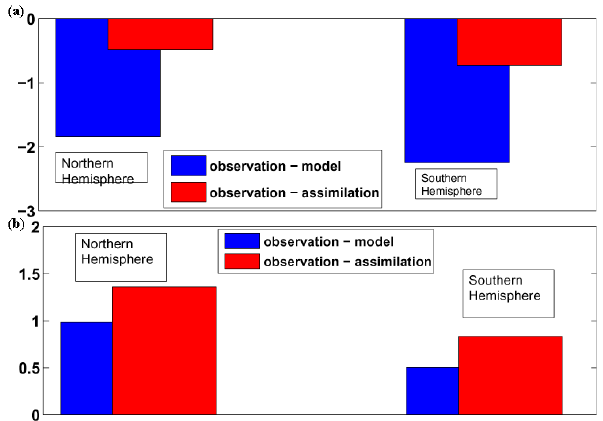
Fig. 6. Mean (a) and standard deviation (b) differences (O − M or O − A) between NOAA/ESRL/GMD cooperative air sampling net- work and model (blue) or analysis (red) fields interpolated to obser- vation locations. These plots are for the entire set of measurements during the years 2005–2006.